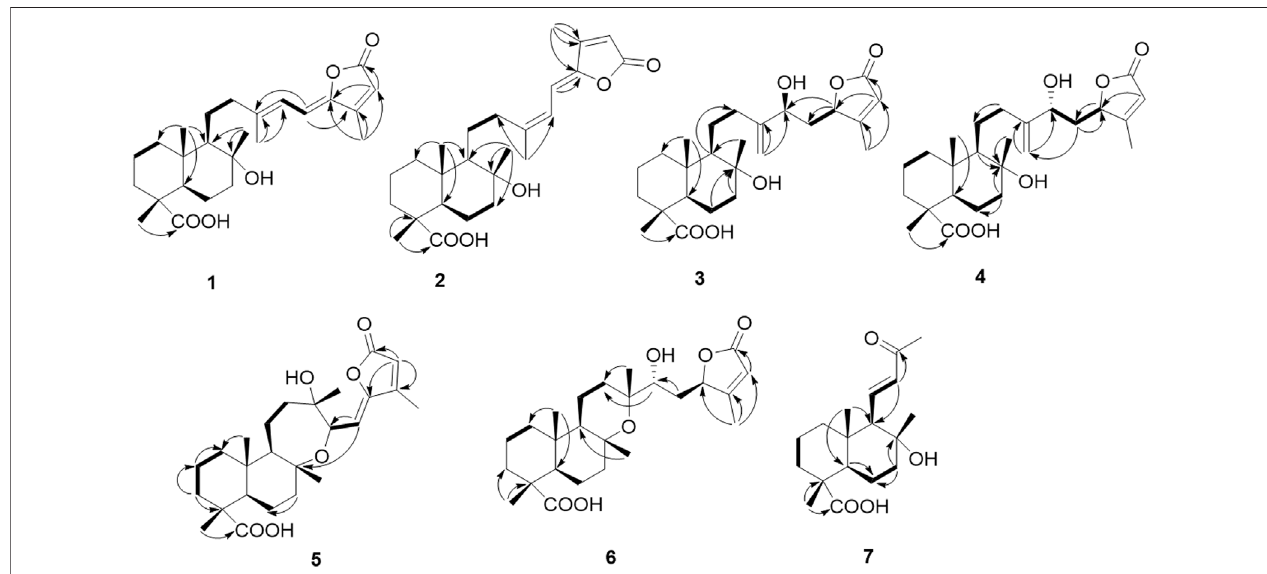
FIGURE 2 | Key 1 H – 1 H COSY (bold) and HMBC (H → C) correlations of 1-7 .